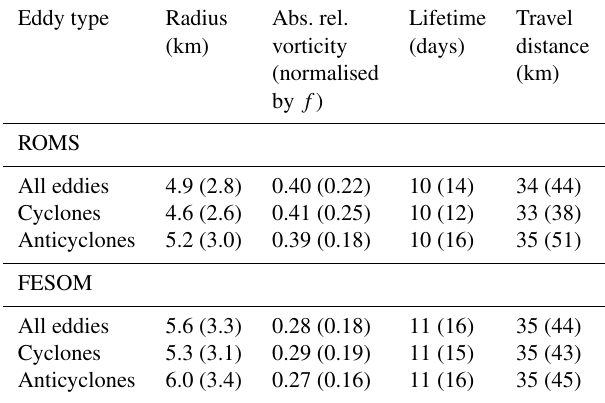
Table 2. Mean properties and their standard deviation (in brackets) for all eddies generated in the area 8 ◦ W–20 ◦ E, 76–82 ◦ N in the years 2006–2009 in ROMS and